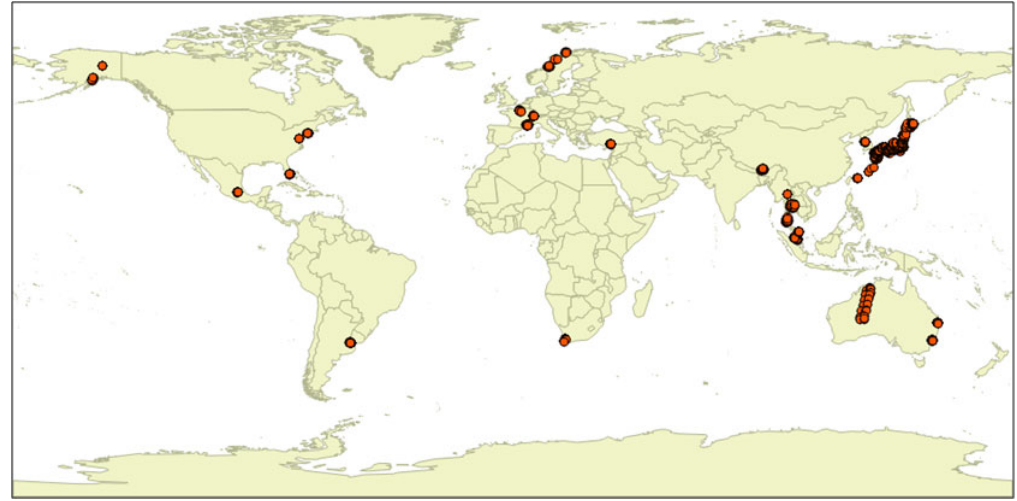
Figure 4. Distribution of 4,628 GCPs in 15 areas used in the validation of DSM-tiles